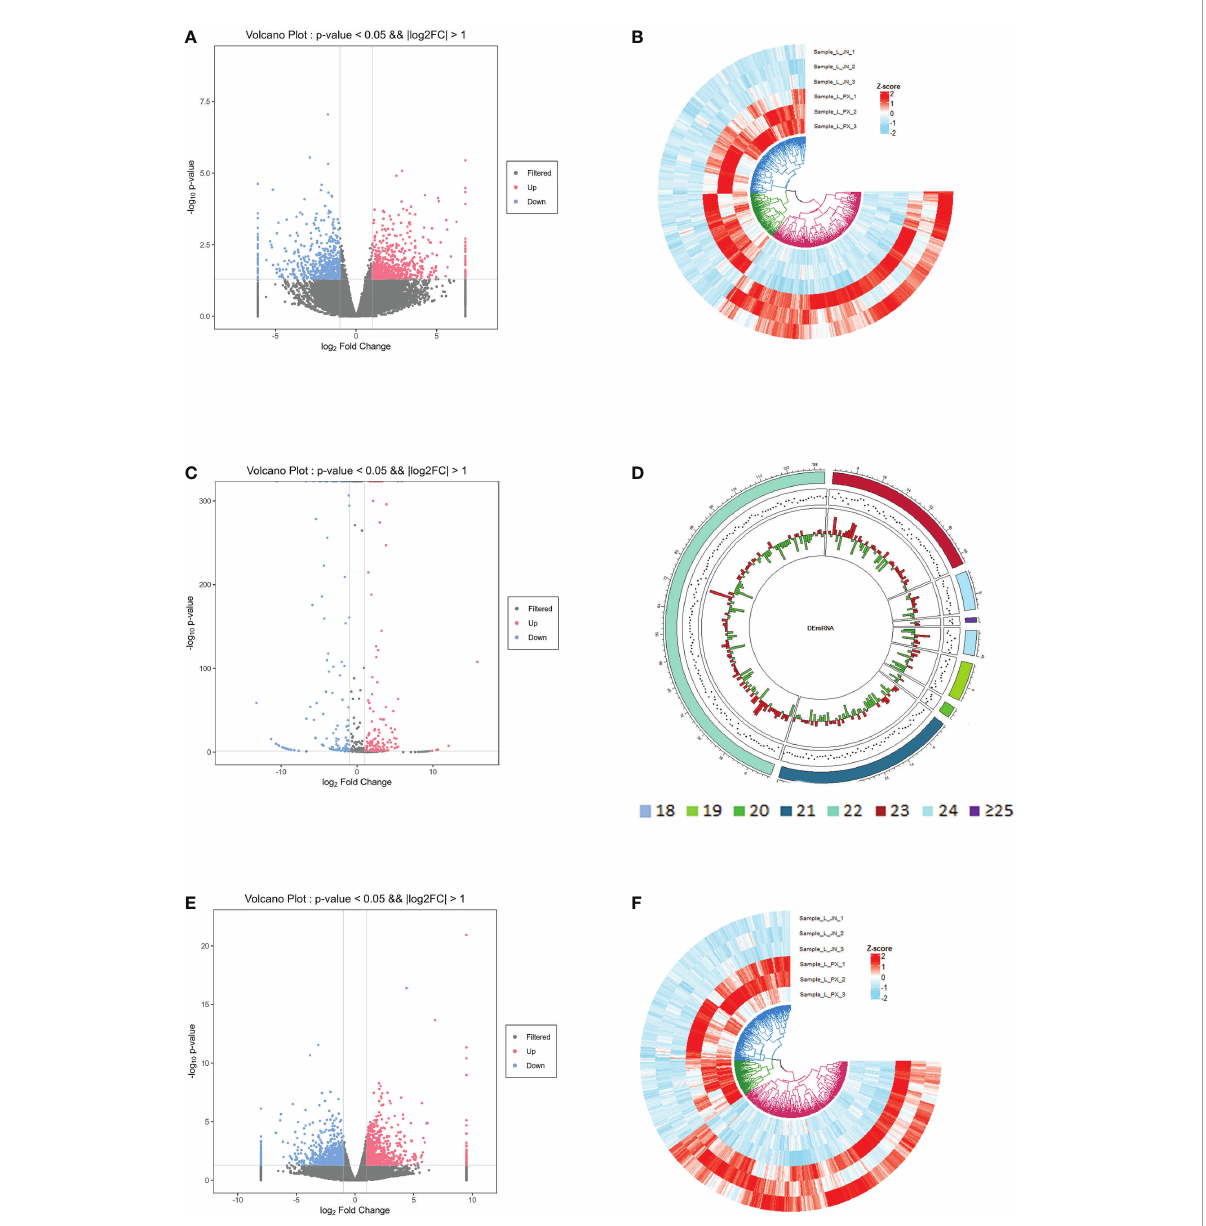
FIGURE 2 Differentially expressed gene information. Differentially expressed lncRNA volcano map (A) and heat map (B) ; differentially expressed miRNA volcano map (C) and length distribution map (D) ; differentially expressed mRNA volcano map (E) and heat map (F)